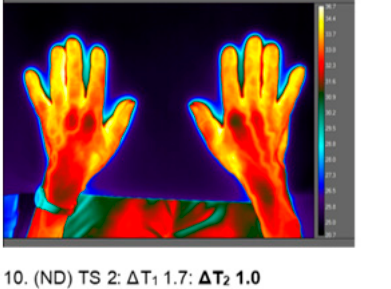
Figure 8. Thermal maps of hand and forearm of 10 residents with the visual appearance of ‘warm’ hands. Figure shows the study group; dementia (D) or no dementia (ND), thermal sensation (TS) rating and temperature difference (°C) for ∆ T 1 and for ∆ T 2 .